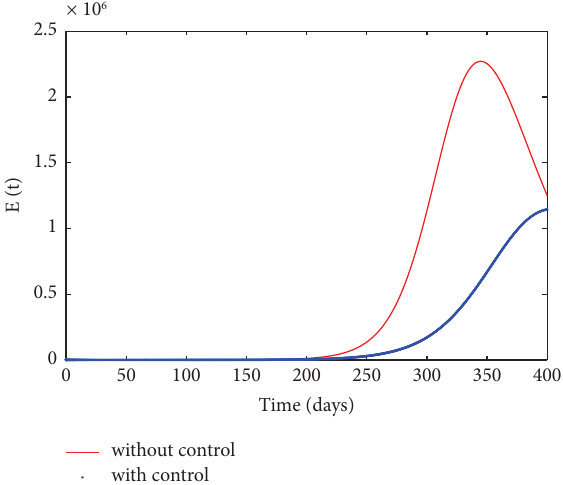
Figure 17: Behaviour of the exposed individuals with and without the vaccination control.